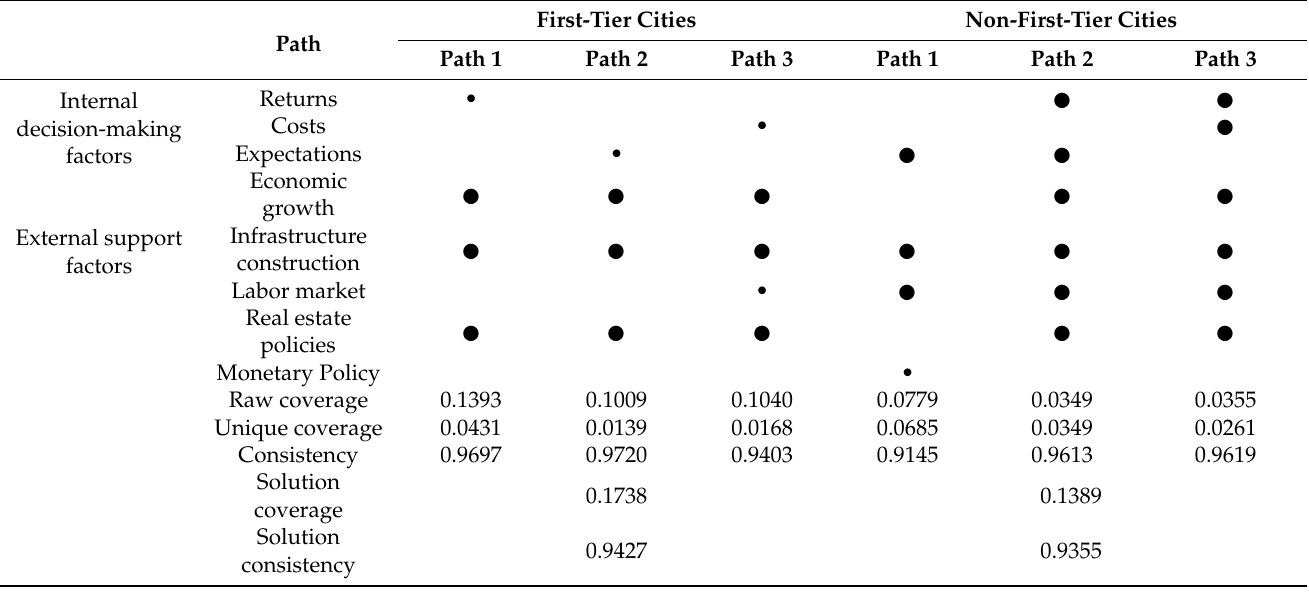
Table 4. Robustness tests for adjusting the level of